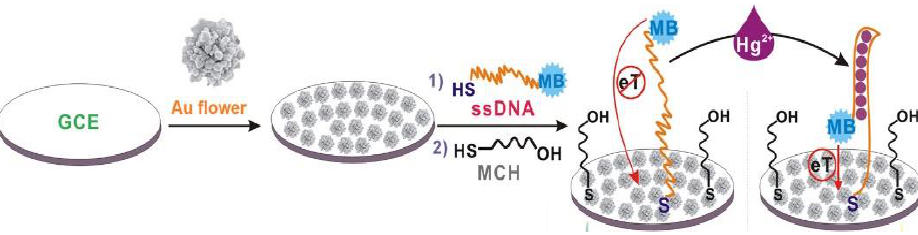
Figure 9. Schematic illustration of signal- on switch aptasensor using “Au nanoflowers” -decorated electrode. Adapted with permission from Zhang et al. [63] (Copyright © (2018)